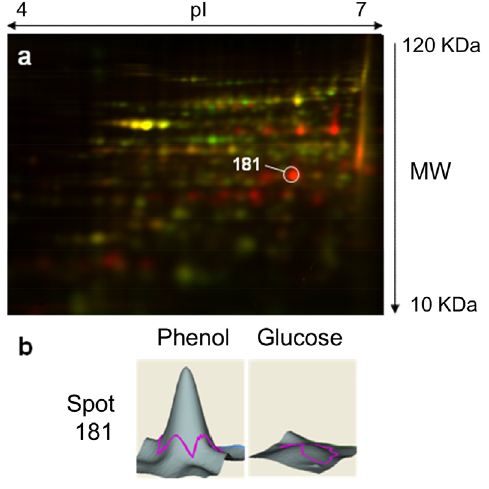
Figure 3. Differential proteome of S.solfataricus 98/2 grown on phenol or glucose. (A) 2D-DIGE gel. Cy2 (yellow): glucose + phenol conditions, Cy3 (green): glucose condition, and Cy5 (red): phenol condition. (B) Relative intensity of spot 181.